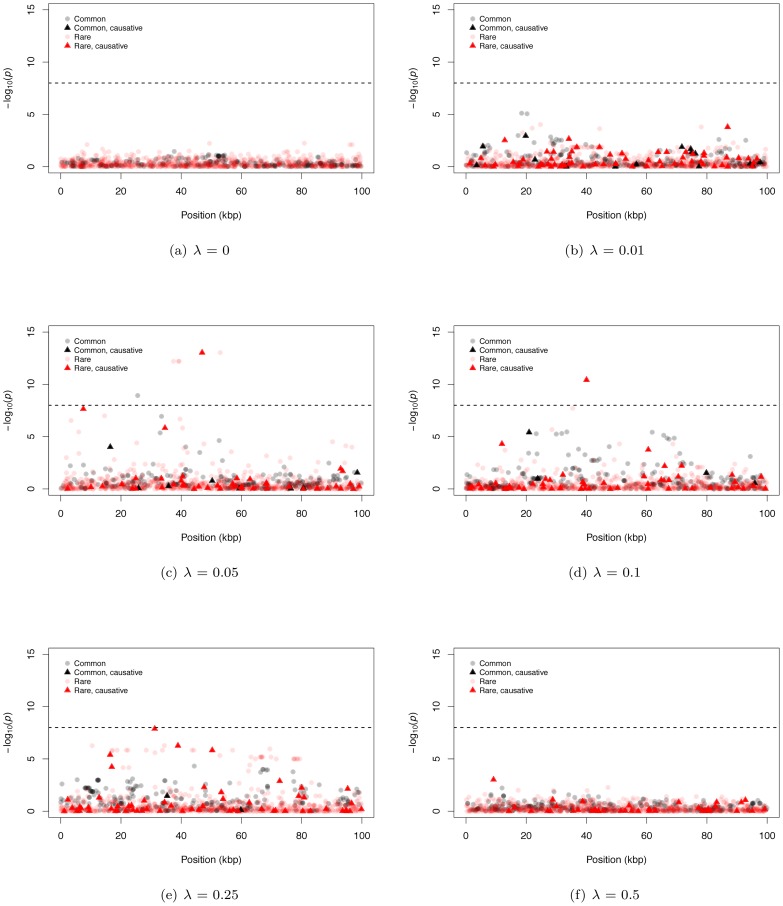
Representative Manhattan plots.The dashed horizontal line corresponds to a p-value of 10−8. (a–f) The −log10 of the p-value of the logistic regression is shown for representative examples for different mean effect sizes of causative mutations (λ). The plots are separated into four classes of mutations: common neutral and causative variants, which could be typed in a GWAS, and rare neutral and causative variants which would only be directly typed by resequencing.